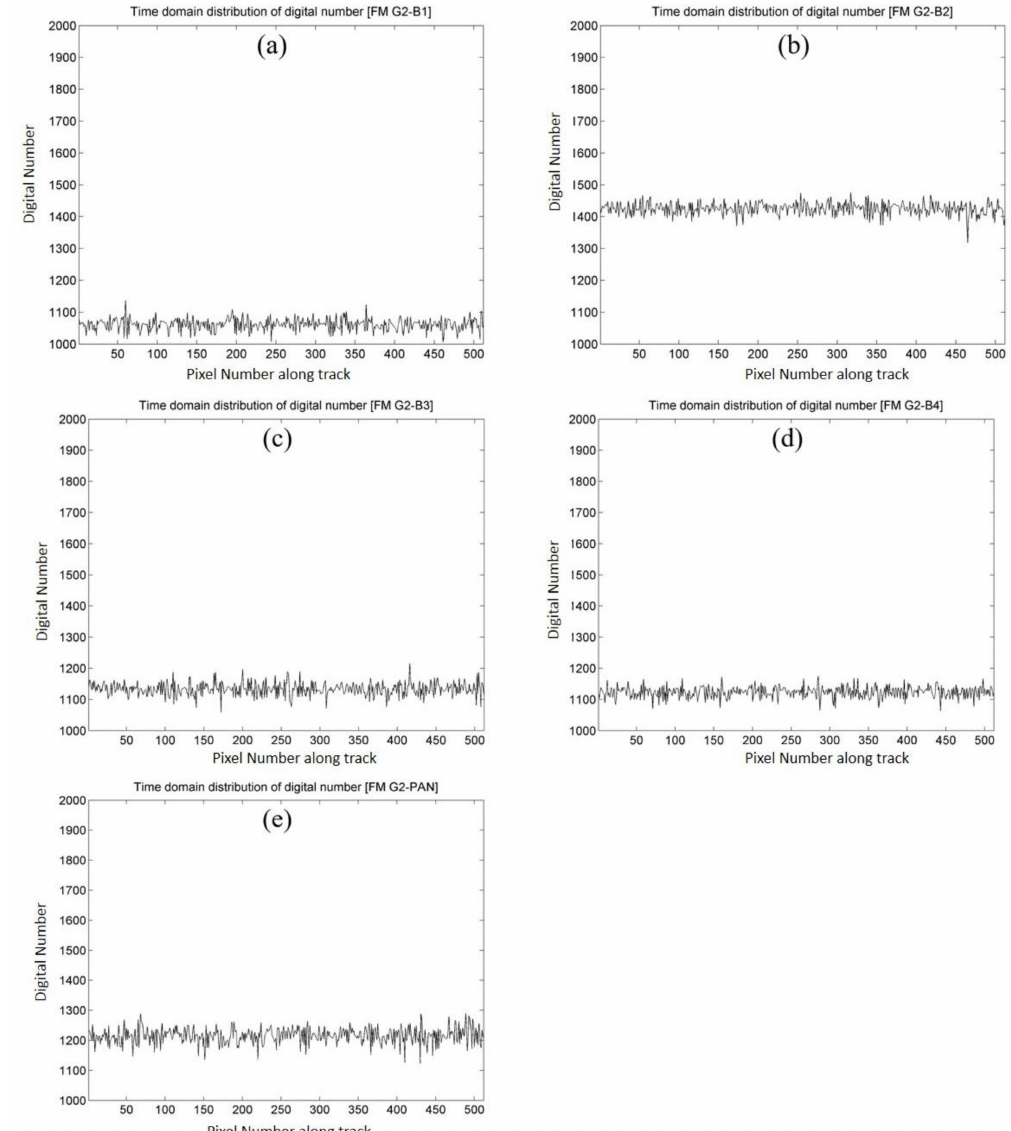
Figure 8. Temporal non-uniformity of grayscale values (digital numbers) for the 100th detector from flying mode test imagery for all bands of gain setting G2. ( a ) Band 1 (blue band); ( b ) Band 2 (green band); ( c ) Band 3 (red band); ( d ) Band 4 (near infrared band); ( e ) PAN (panchromatic